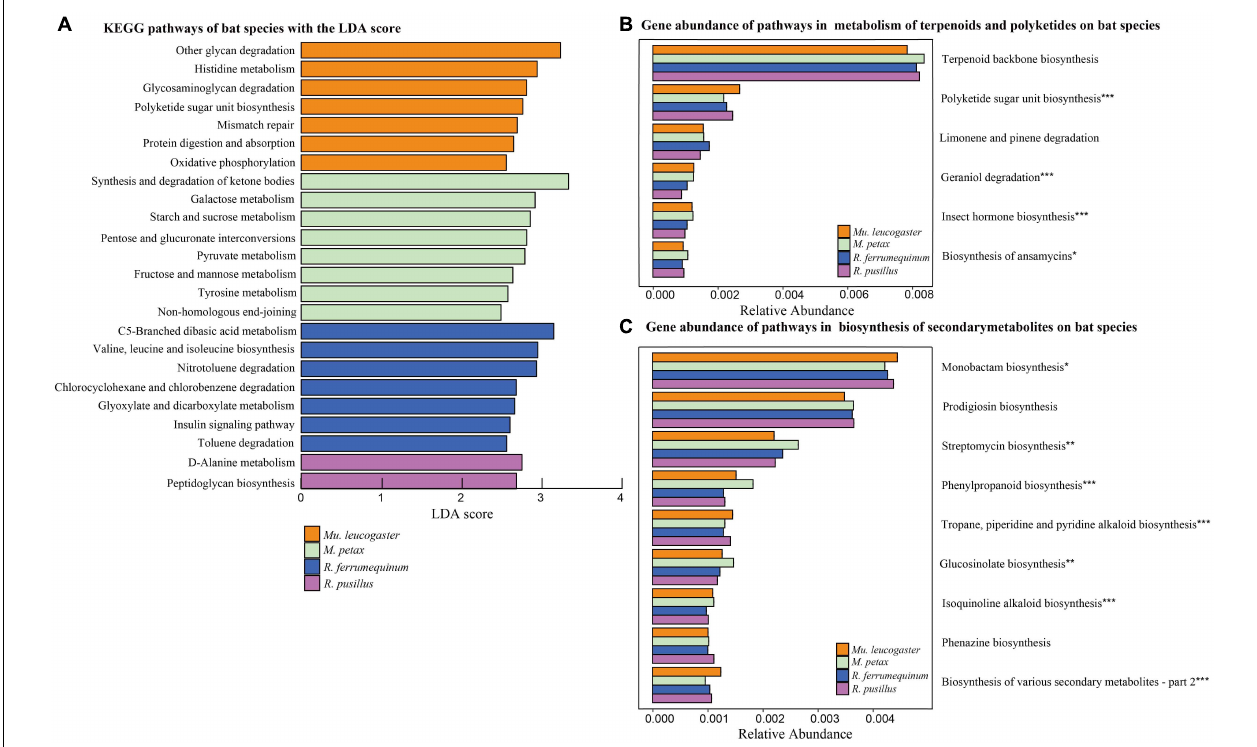
FIGURE 3 | Functional gene predictions. (A) KEGG pathways of bat species based on LEfSe analysis. KEGG pathways with the highest linear discriminant analysis (LDA) scores. Gene abundance of pathways within the metabolism of terpenoids and polyketides (B) and biosynthesis of secondary metabolites (C) on bat species. The gene relative abundances of pathways > 0.1%. Asterisks indicate significant difference among groups. * P < 0.05, ** P < 0.01, *** P < 0.001.